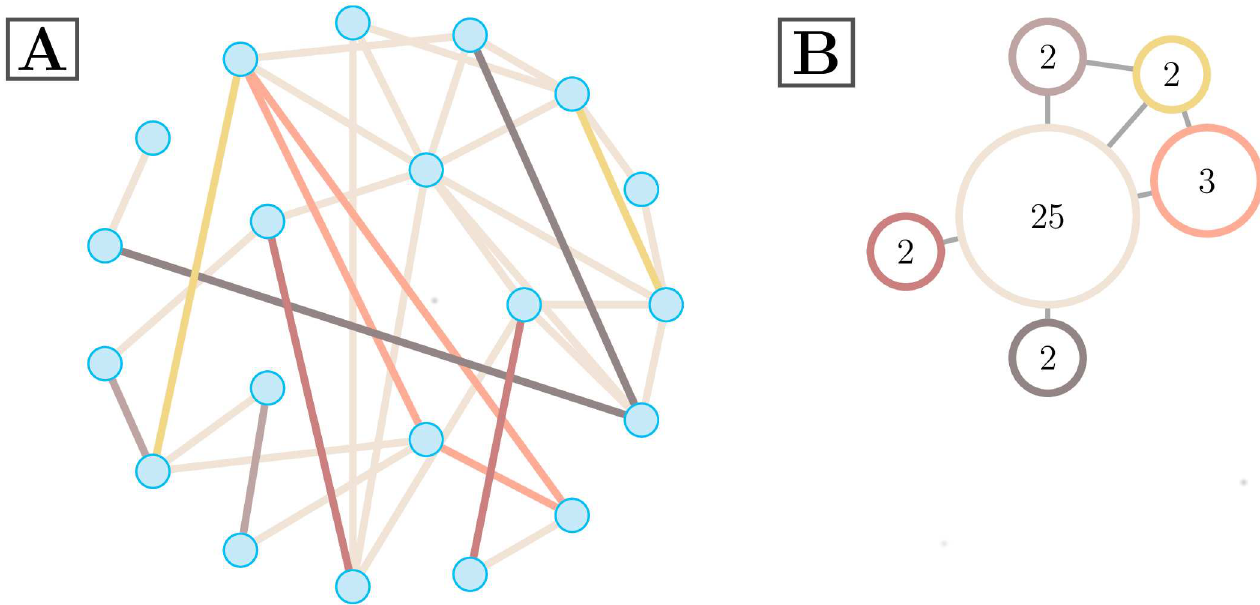
Fig 2. Example ξ 0 . Two depictionsof a representative hypergraphon 20 nodes. The hypergraph with singletonsremoved is shown in (A), where edge color represents hyperedge assignment. The size of a particular hyperedge is the number of edges in it, as in Eq 2. This illustrative hypergraph is comprised of six distinct hyperedges of various sizes. An alternative hypergraph representation is depicted in (B), where colors directly correspondto (A). Each hyperedge in the hypergraph is represented by a single vertex. Vertex labels correspond to hyperedgesize, and edges are drawn when hyperedges connect to at least one common